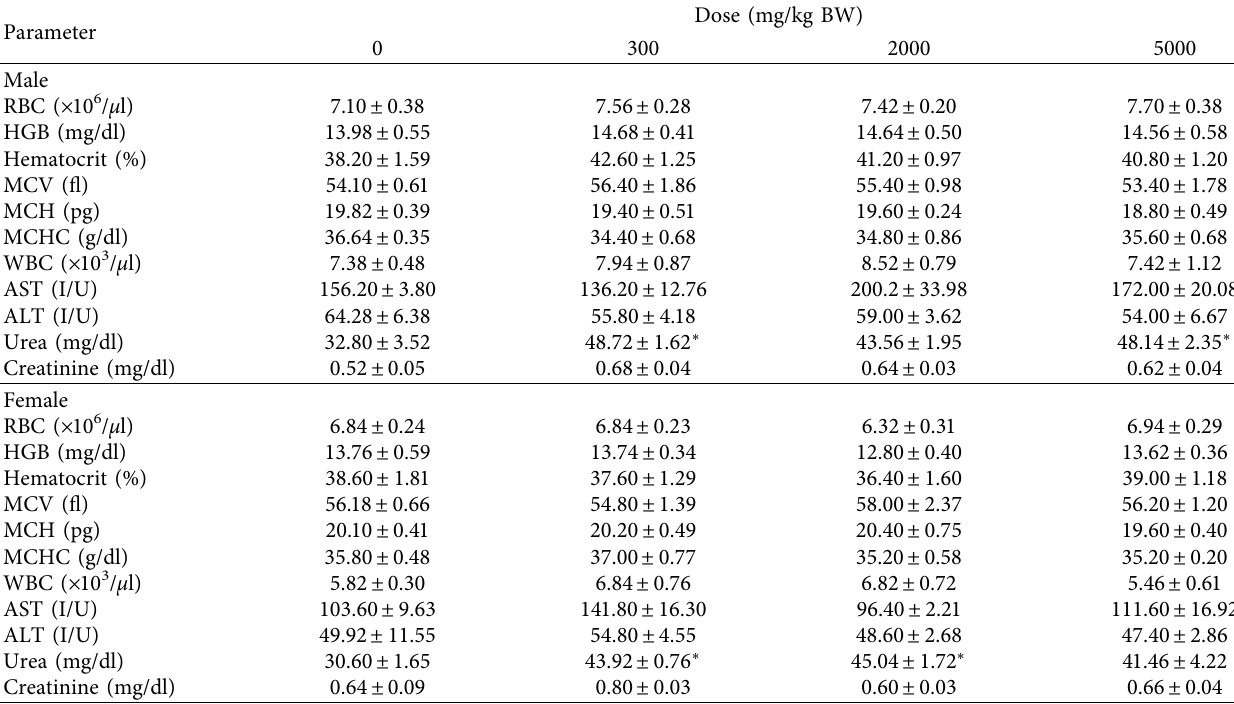
RBC: red blood cell count, HGB: hemoglobin, MCV: mean corpuscular volume, MCH: mean corpuscular hemoglobin, MCHC: mean corpuscular he- moglobin concentration, WBC: white blood cell count, AST: aspartate aminotransferase, ALT: alanine aminotransferase. Data are means ± SEM for groups of five rats/sex/dose ∗ ( p < 0 . 05 ) vs. control